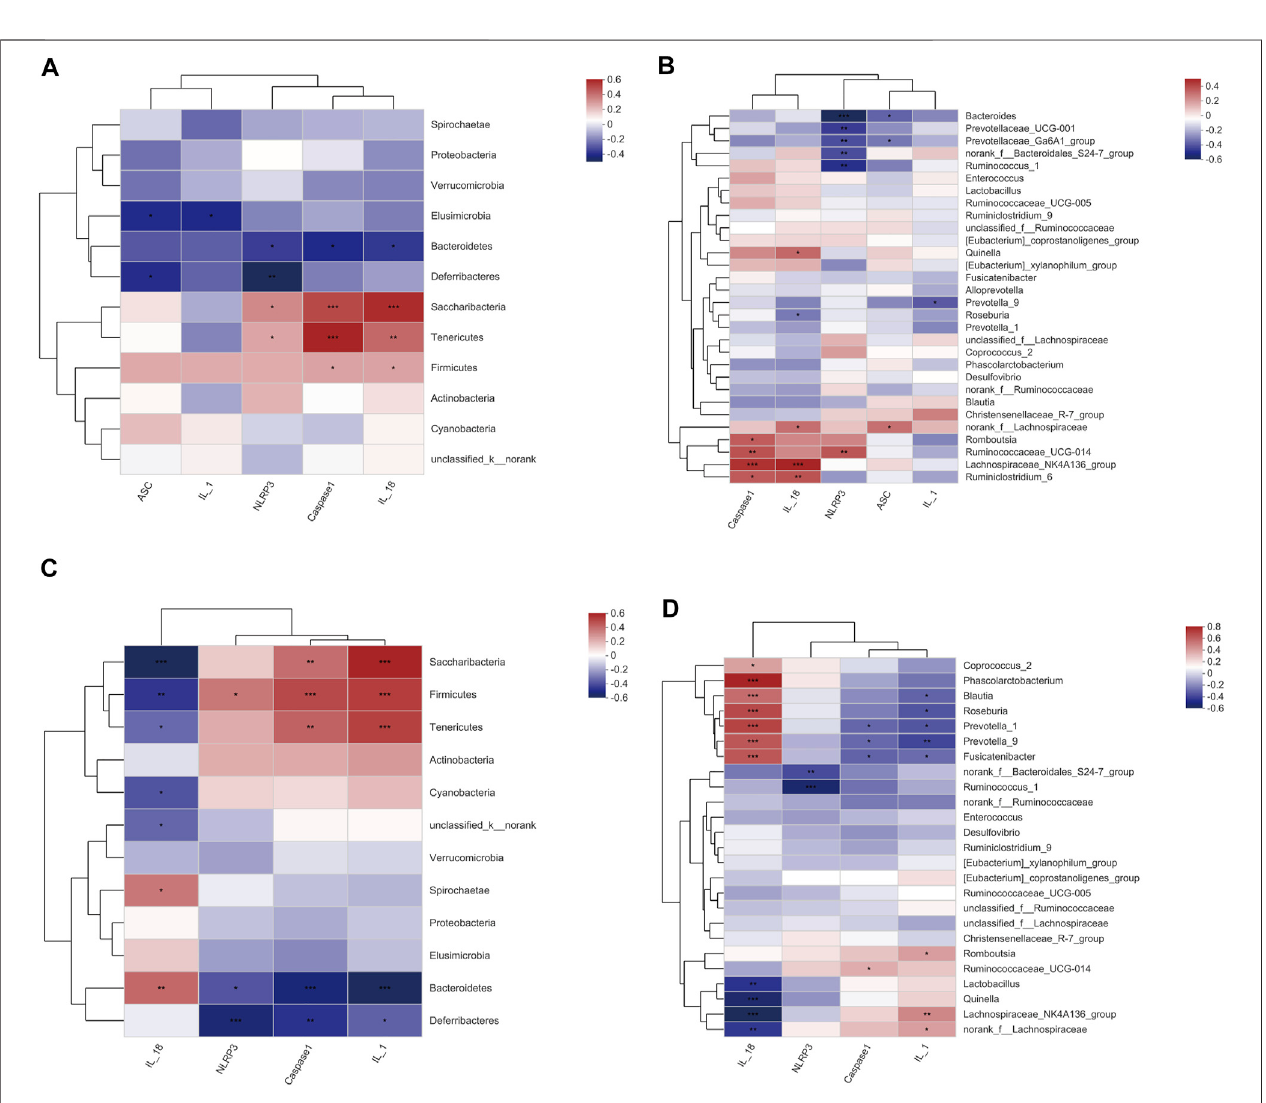
FIGURE7| ASpearman ’ scorrelationbetweenthececalmicrobiotaandNLRP3in fl ammasomeinthececumtissueandserum. (A) Correlationsbetweenthececal microbiota (phylum level) and NLRP3 in fl ammasome mRNA in the cecum tissue. (B) Correlations between the cecal microbiota (genus level) and NLRP3 in fl ammasome mRNA in the cecum tissue. (C) Correlations between the cecal microbiota (phylum level) and NLRP3 in fl ammasome in the serum. (D) Correlations between the cecal microbiota(genuslevel)andNLRP3in fl ammasomeintheserum. R value,thecloserthisvalueisto1,themorepositivethecorrelation,whilethecloseritisto − 1,the more negative the correlation. ( p ≤ 0.001) indicates an extremely signi fi cant correlation, (0.001 < p ≤ 0.01) indicates a very signi fi cant correlation, (0.01 < p ≤ 0.05) indicates a signi fi cant correlation. The data are expressed as the mean ± SEM, ( n (cid:2) 6).